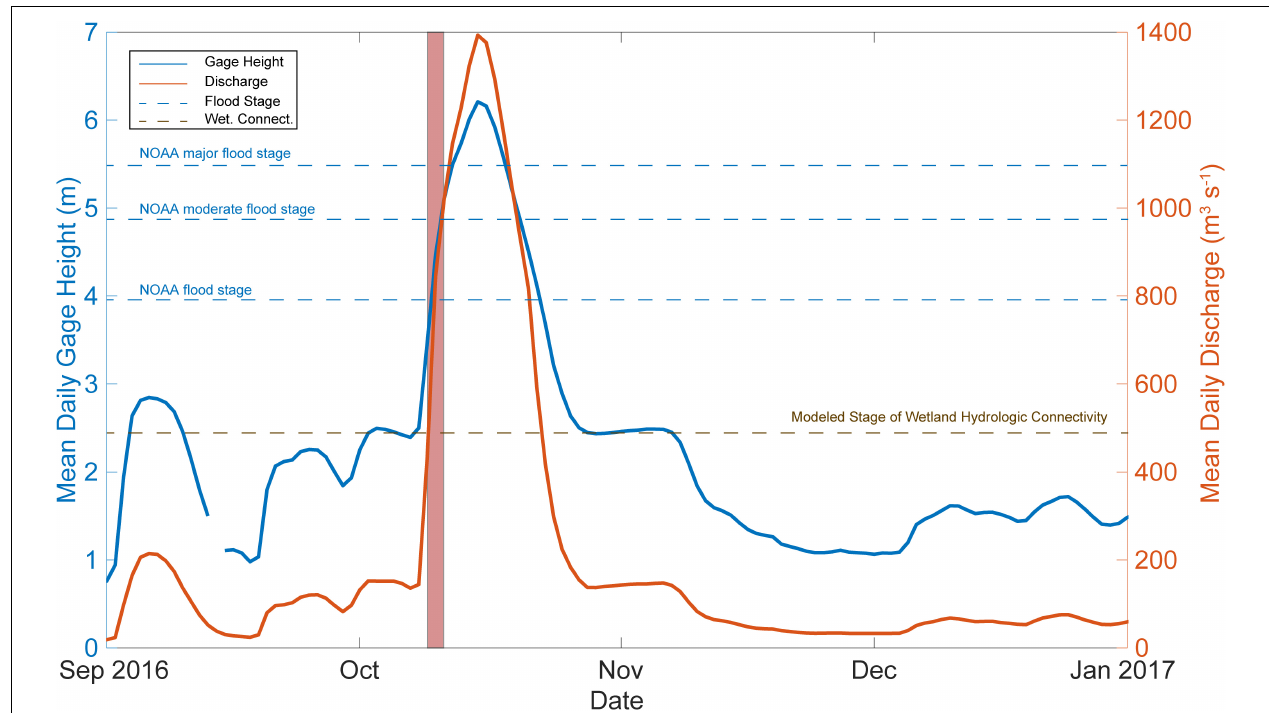
FIGURE 2 | Hydrograph. Mean daily gauge height and mean daily discharge from USGS gauging station 02021814 near Fort Barnwell, NC prior to and after Hurricane Matthew (September 2016-January 2017). NWS flood stage, moderate flood stage, and major flood stage are plotted in blue dotted lines. Limit of wetland hydrologic connectivity from geospatial model plotted in brown dotted line. Red shaded box indicates period of Hurricane Matthew in North Carolina (08–10 October,